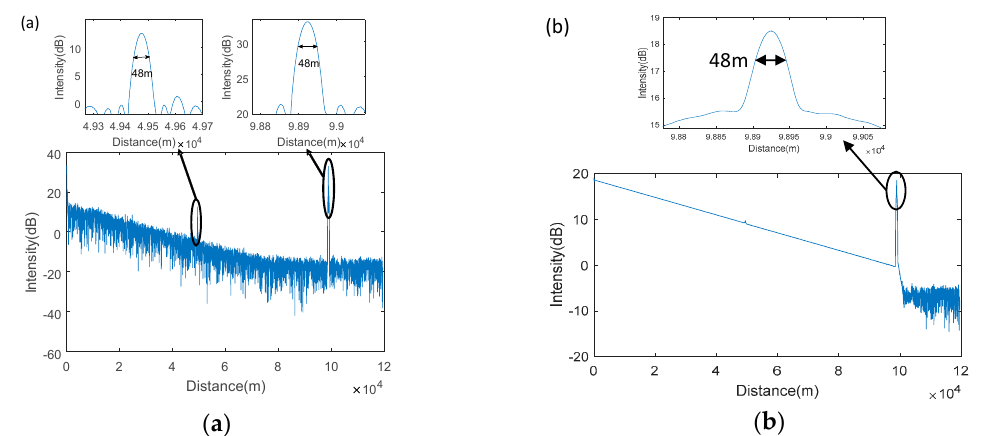
( b ) Figure 7. Measurement results of the rectangular short-time fractional Fourier transform window. ( a ) Considering only the primary linear frequency modulation signal in the backscattered signal. ( b ) The blue curve represents the results obtained when adding the direct current component, and the red curve the results of a conventional optical time domain reflectometry (OTDR) under the same experimental conditions. As shown in Figure 7, when the STFrFT window is rectangular, there are a series of evident sidelobes around the high reflection peak in the reflection event measured. To suppress them, we use the Hamming window as the STFrFT window, and the results are shown in Figure 8. Figure 8a illustrates the measurement result when only the primary LFM signal in the backscattered signal is considered. A comparison with the results in Figure 7 suggests that the measured reflection event is mainly a high reflection peak with almost no sidelobes. However, the spatial resolution defined by the FWHM of the mainlobe is reduced by a factor of 1.6 to a width of 48 m, which is almost the same